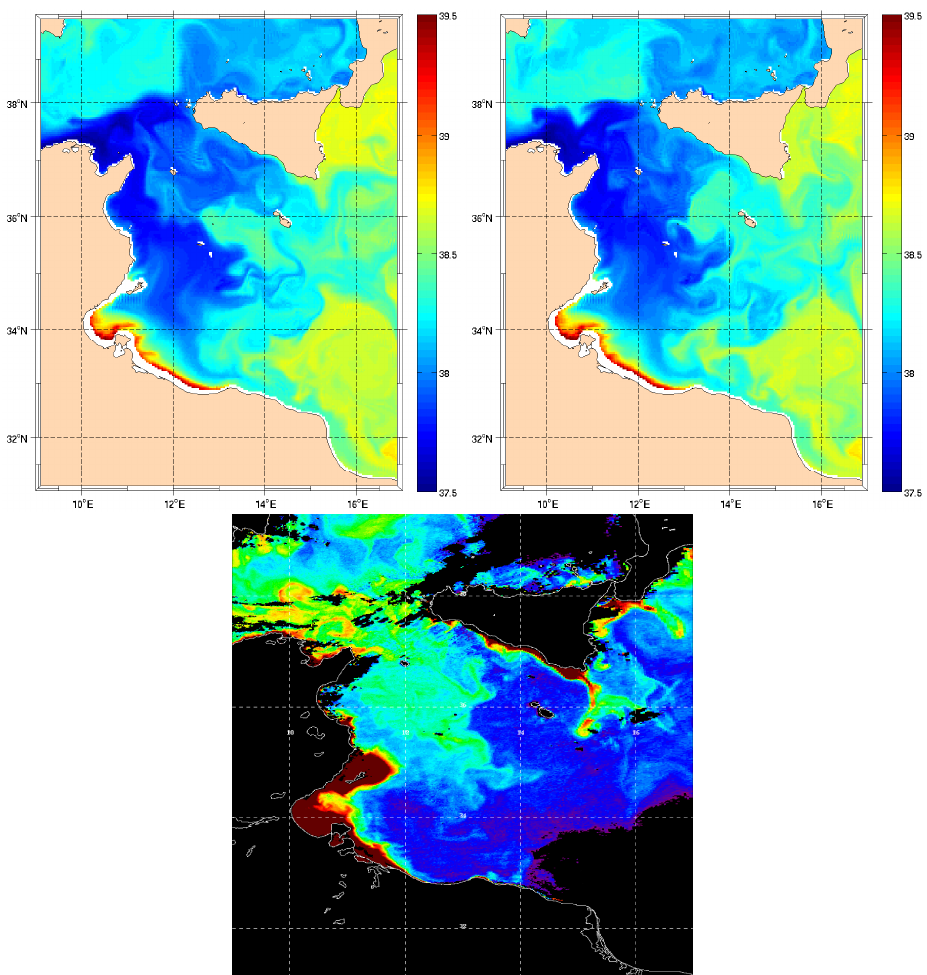
Fig. 4. April 22 th , 2008. Salinity (psu) for SIM (left) and AN (right). Bottom panel shows satellite Chlorophyll-a from MODIS-AQUA.